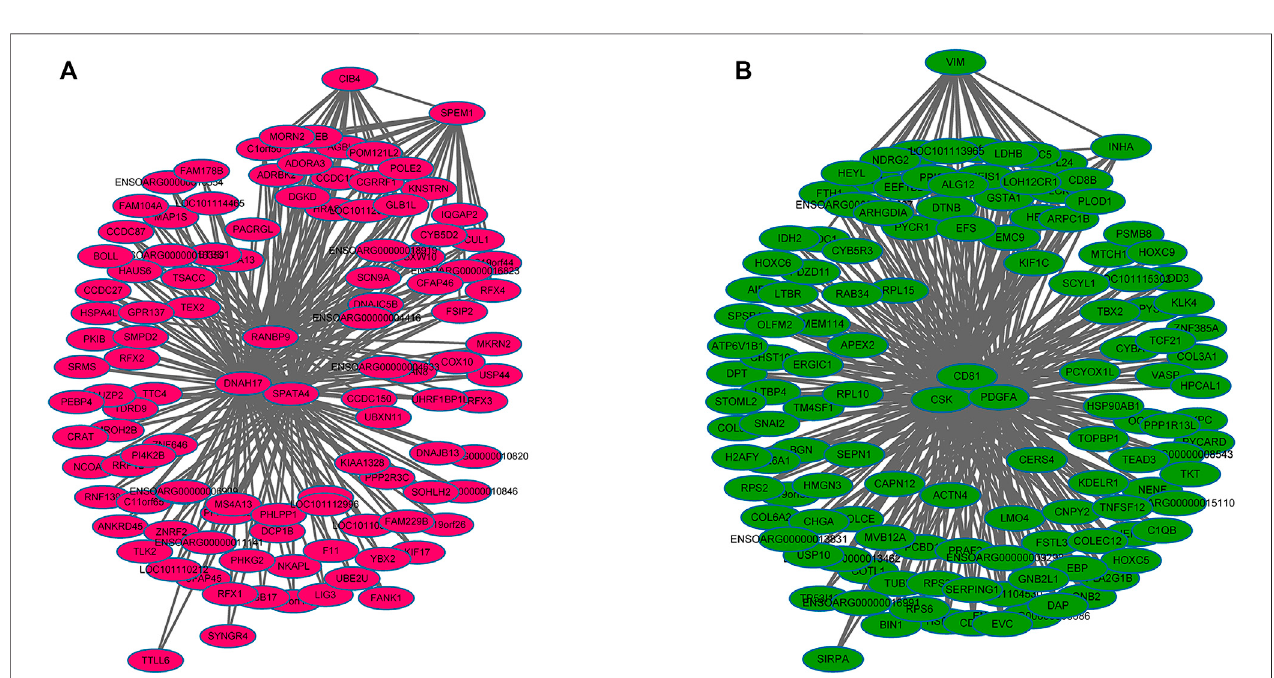
FIGURE 8 | The regulation network of key genes related to testis phenotypic trait. (A) The regulation network of key genes that were positively in testis phenotypic traits, which indicated that some hub-genes such as RANBP9 , DNAH17 , SPATA4 , CIB4, and SPEM1 were identi fi ed (B) The regulation network of keygenes that were negatively in testis phenotypic traits, which indicated that some hub-genes such as CD81 , CSK , PDGFA , VIM, and INHBA were identi fi ed.